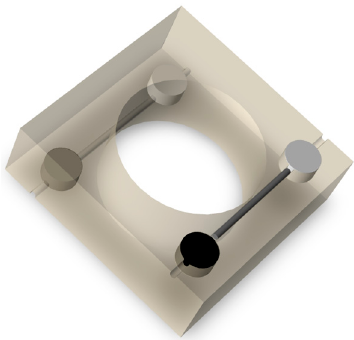
Figure 10. Association for Testing Materials (ASTM) E 2003 standard services after 3d modelling that consists of polytetrafluoroethylene body, 99.9% cadmium wire, 99.9% lead disk (black), and 40% elemental boron nitride disk (white) [40].